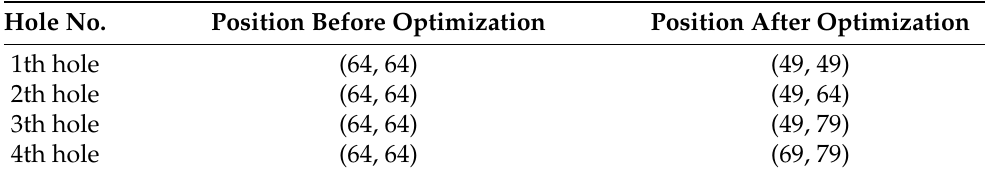
Figure 9. Comparison between surrogate model prediction and FEM result for four-holes case: ( a ): temperature field with an optimized mask using a CNN surrogate model; ( b ): temperature field with an optimized cover using the FEM method; ( c ): quantitative comparison of the two results. Table 4. The position optimization of the four-holes